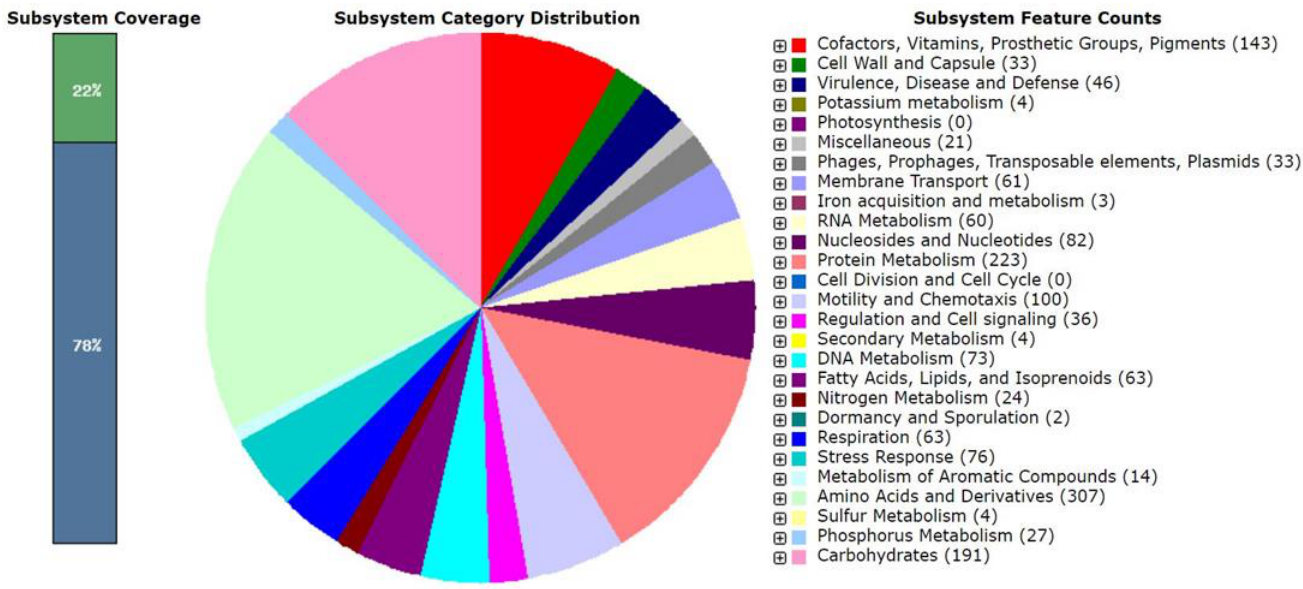
Figure 5. Subsystem category distribution of strain WH53 T based on RAST annotation server (https://rast.nmpdr.org/) (accessed on 28 April 2021).